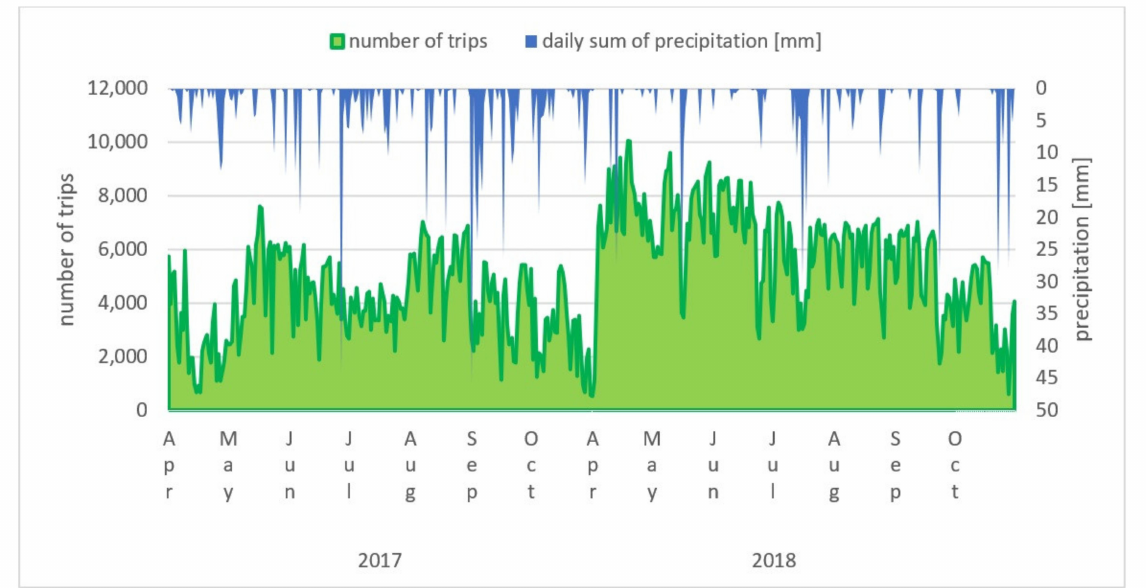
Figure 7. Daily number of ŁPB trips against differentiation of daily totals of precipitation in Ł ó d´z in 2017 and 2018. Source: own elaboration based on data from the Ł ó d´z City Hall and archival data of the Institute of Meteorology and Water Management at the National Research